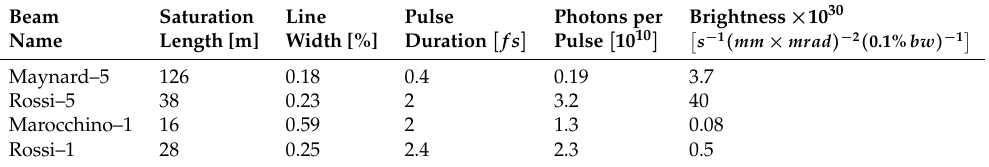
Table 5. Results of the time-dependent simulations with longitudinal dynamics, obtained with PERSEO .